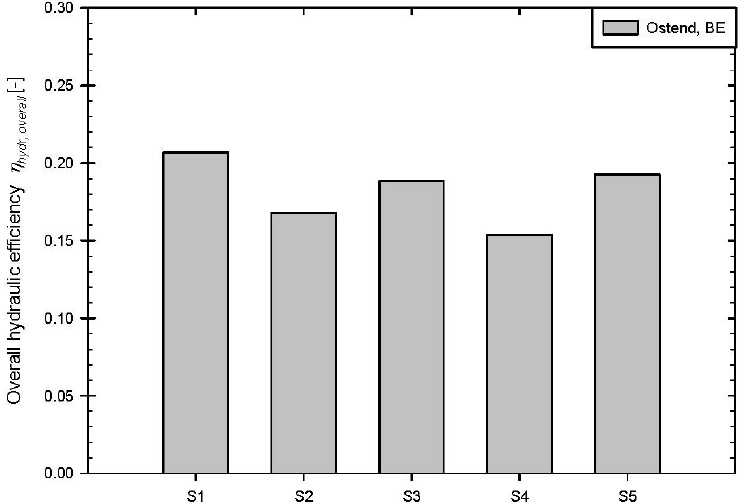
Figure 8. Comparison between effects of five scenarios on the overall hydraulic efficiency for test site in Ostend, Belgian Continental